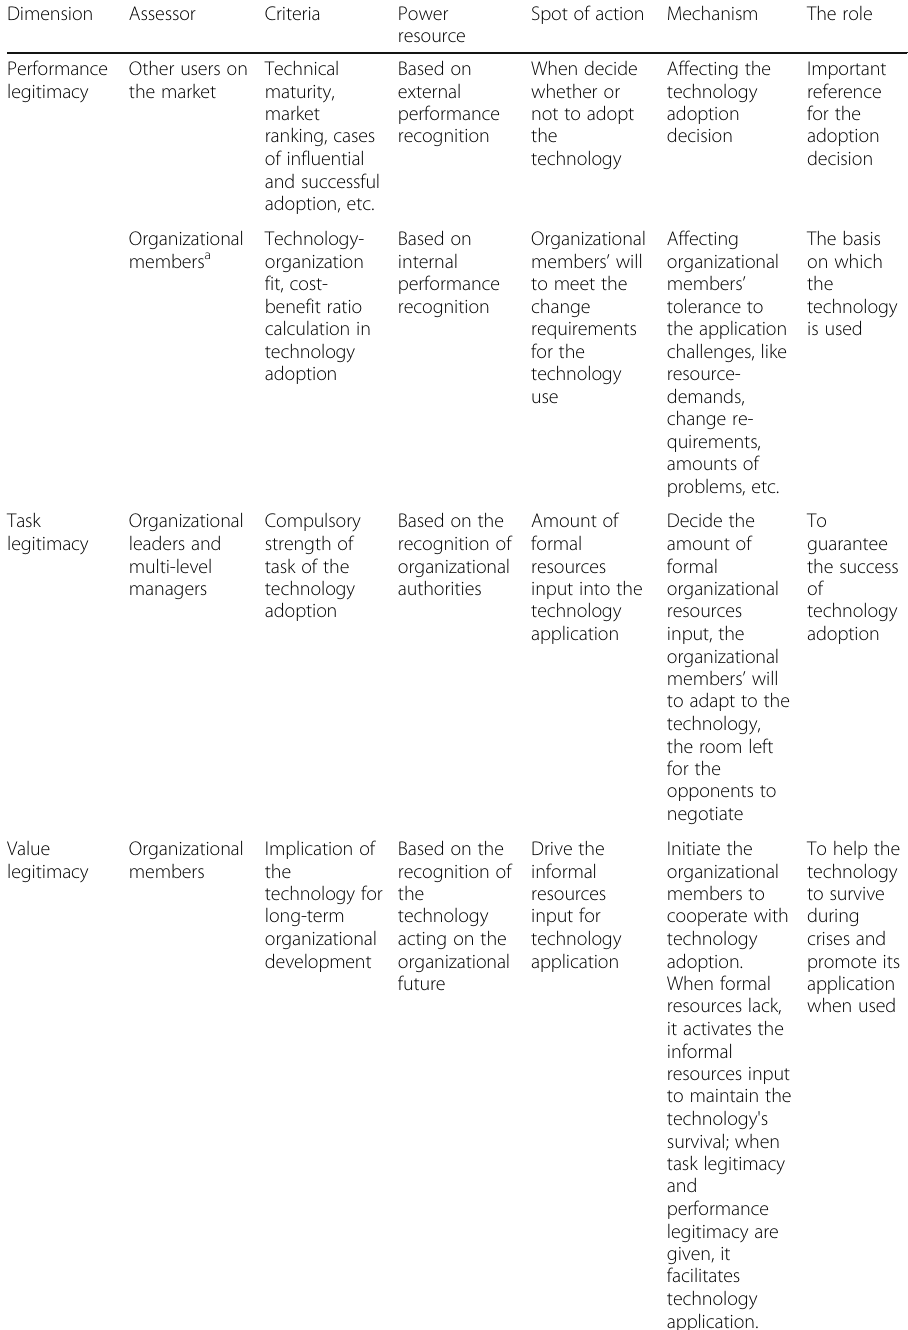
Table 1 Comparison of the three dimensions of the intra-organizational legitimacy of technology Dimension Assessor Criteria Power Spot of action Mechanism The role resource Performance Other users on Technical legitimacy the market maturity, performance adoption, etc.